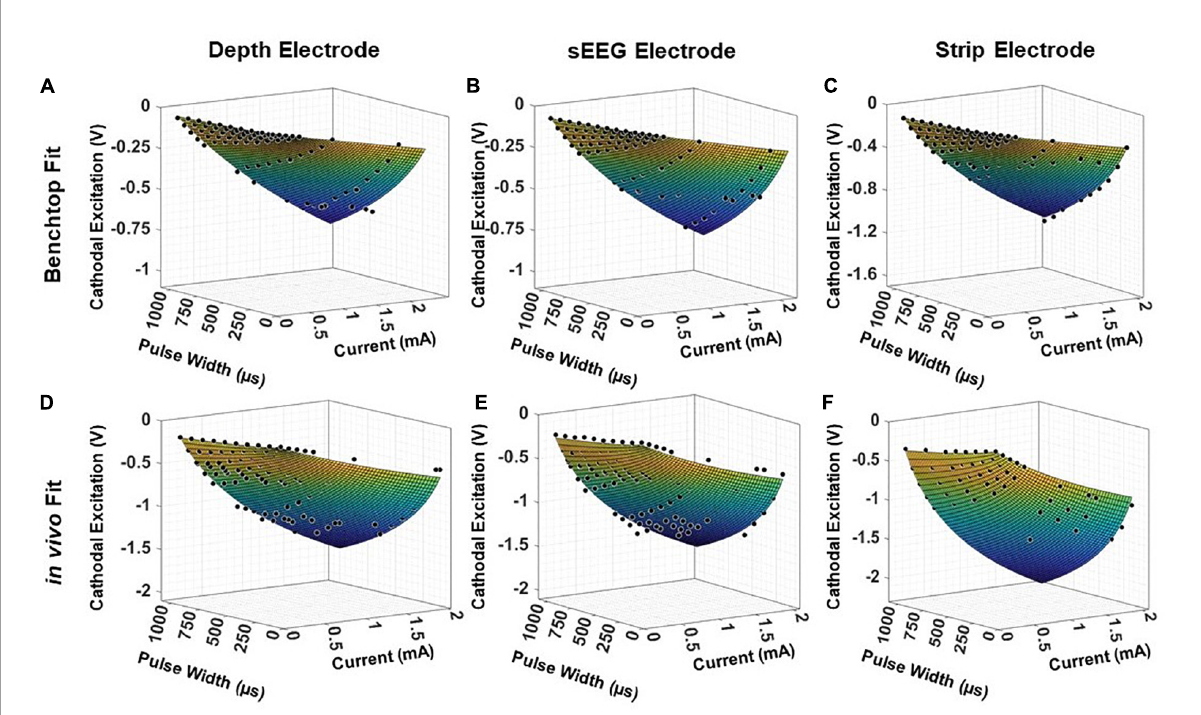
FIGURE8 Fitting results for clinical electrodes measured on a pig’s cortex, plotted as a function of the magnitude of the input current and the pulse width, for a (A,D) depth electrode, (B,E) sEEG electrode, and (C,F) strip electrode, in benchtop and in vivo measurements,